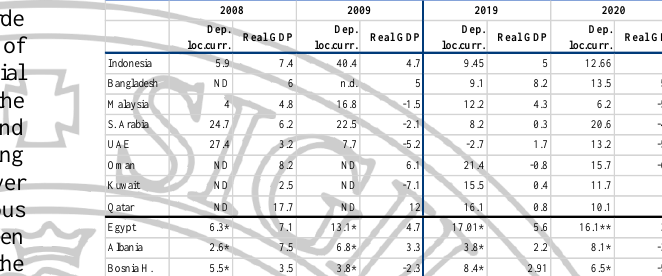
Table 1. Deposits in Islamic banks and real GDP in the major Islamic countries (yoy % change). Note: (*) central banks’ database referring to the entire banking system; (**) Source: EIU; NA= not available. Source: our calculations on EIU and BankFocus BvD